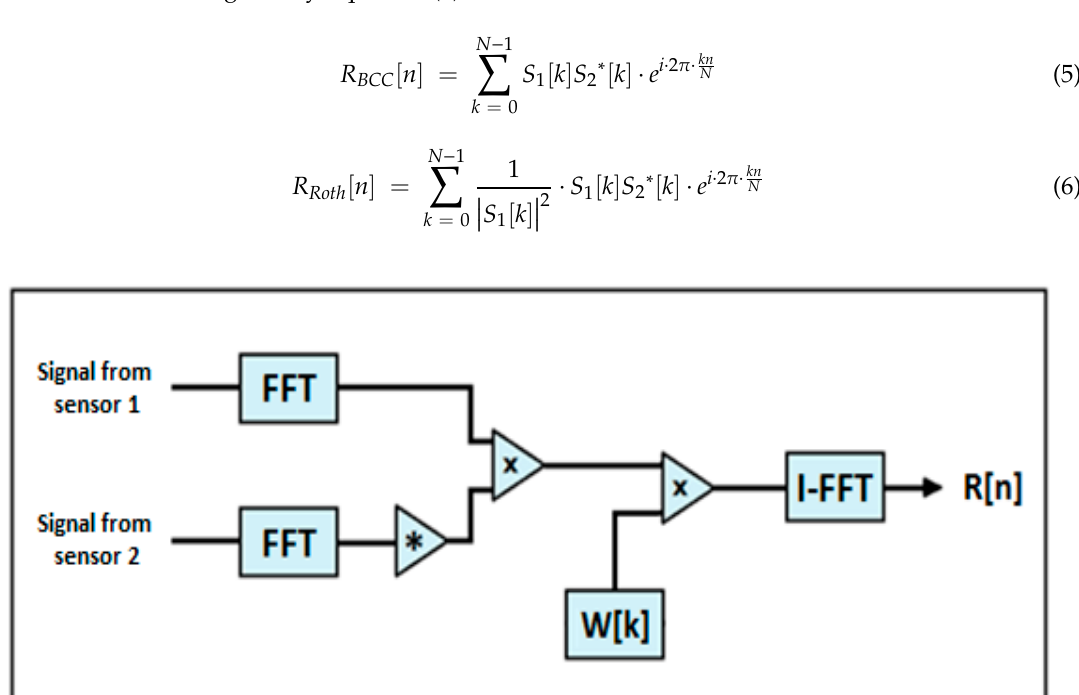
Figure 2. Generalized cross-correlation algorithm.